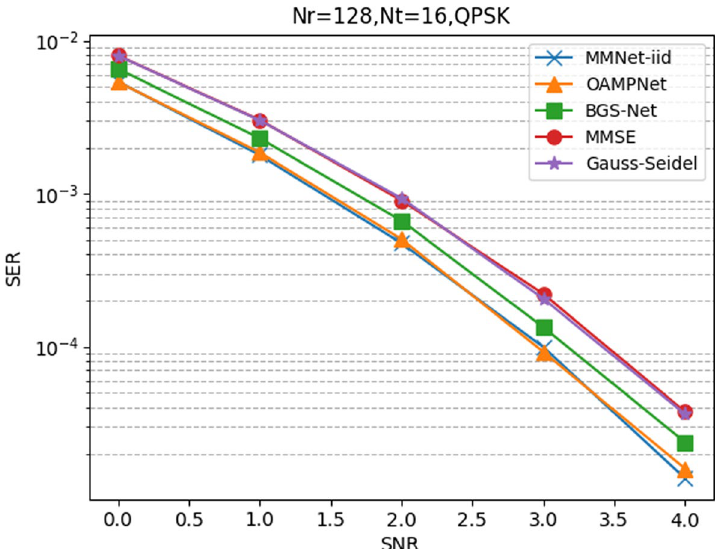
Fig. 15 SER performance comparison of different algorithms under N t = 16,N r = 128 , QPSK, SAUE